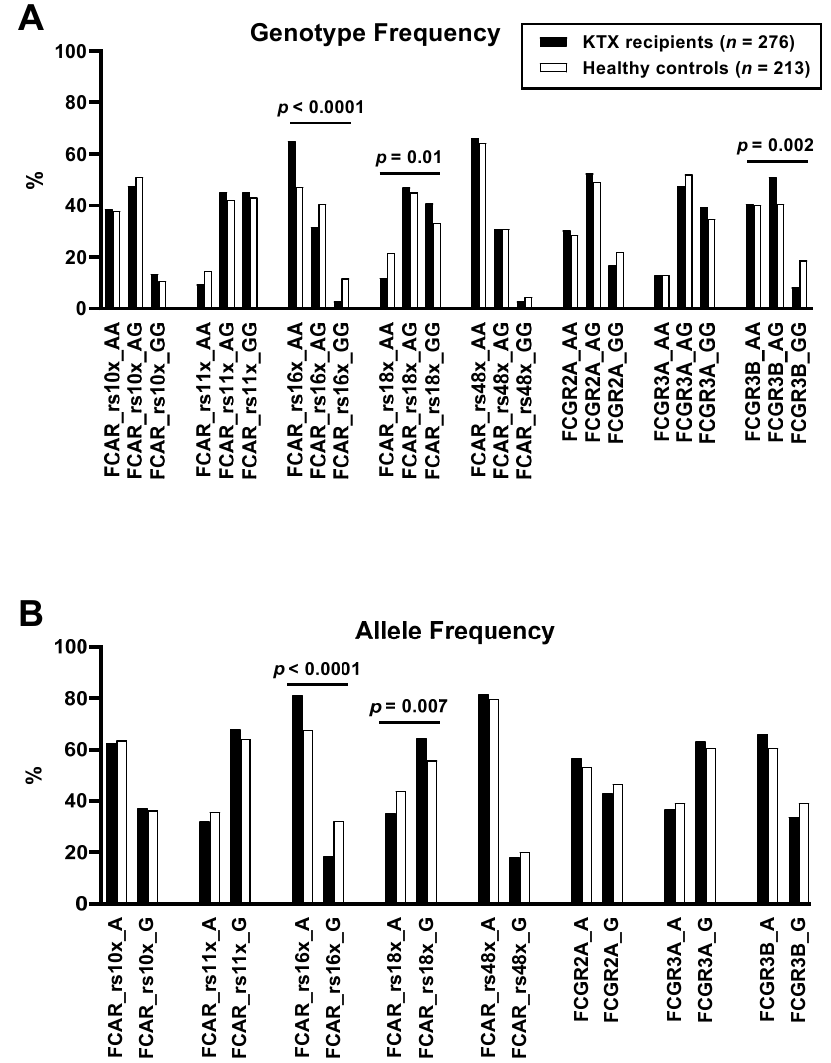
Figure 4. Genotype ( A ) and allele frequencies ( B ) of Fc α and Fc γ receptor polymorphisms (FCAR and FCGR, respectively) in 276 kidney transplant recipients with graft failure (KTX) and in 213 healthy controls. Data were compared by Fisher’s exact test. rs10x, rs10402324; rs11x, rs11084377; rs16x, rs16986050; rs18x, rs1865097; rs48x, rs4806608; 2A, rs1801274; 3A, rs396991; and 3B, rs35139848.